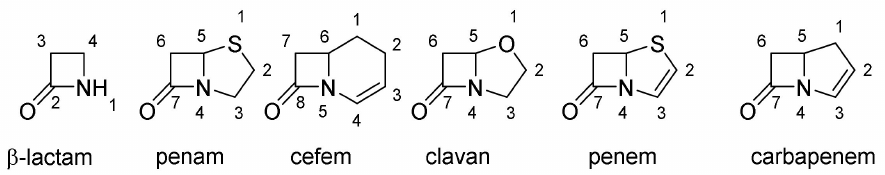
Figure 4. Naturally occurring β -lactams backbones